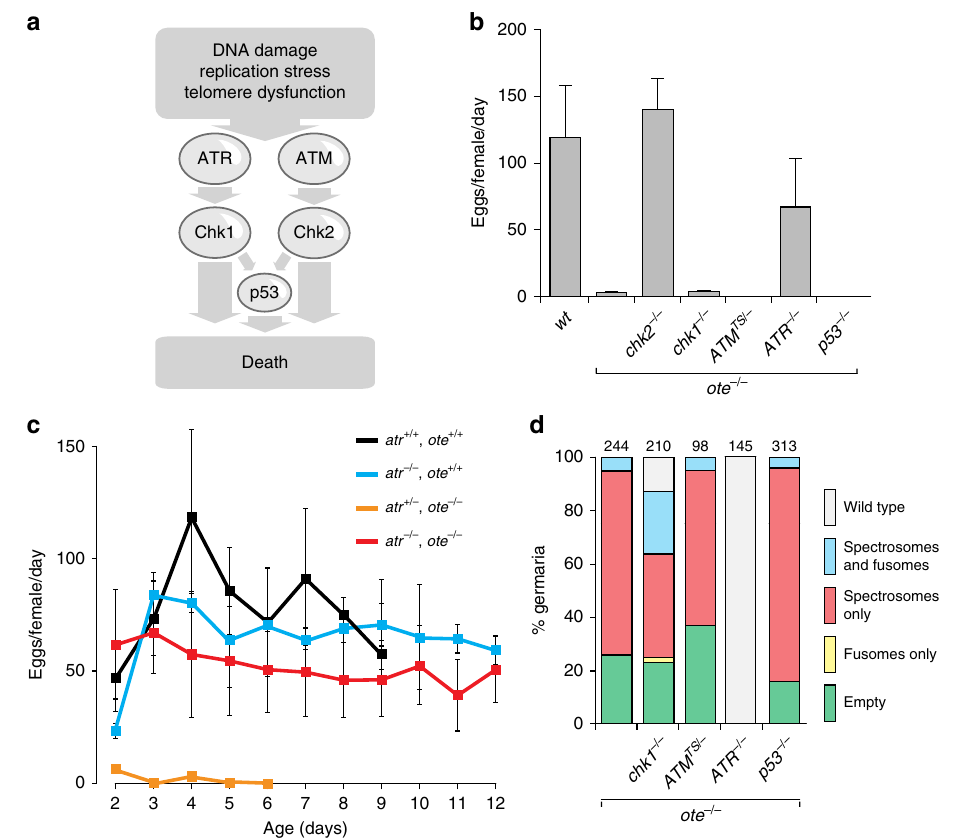
Fig. 3 Select DDR components contribute to the checkpoint pathway in ote mutants. a Schematic representation of signaling through the DNA damage response (DDR) pathway. Common triggers that activate the ATM and ATR responder kinases are shown. The responder kinases canonically activate the Chk2 and Chk1 transducer kinases, which signal to p53 and cause cell death. b Quanti fi cation of peak fecundity (eggs per female per day) of ddr, ote double- mutant females crossed to ote + / + males. Genotypes are noted below each bar, with ote − / − corresponding to ote B279G/PK . Error bars represent the standard deviation from a minimum of two independent experiments, each using 7 – 15 females. c Fecundity (eggs per female per day) of ddr, ote double-mutant females of indicated genotypes, crossed to wild-type males, with ote − / − corresponding to ote B279G/PK . Genotypes are noted above the graph. Error bars indicate the standard deviation from a minimum of three independent experiments with 7 – 15 females each. Wild-type data from Fig. 2c. were included in the graph as a reference. d . Quanti fi cation of germarial phenotypic classes (noted to the right) in 2-day-old ddr, ote double-mutant females, with ote − / − corresponding to ote B279G/PK . Number of germaria assessed from at least ten females is noted above each